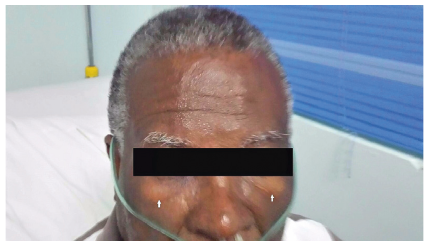
Figure 1: The white arrows indicate periorbital